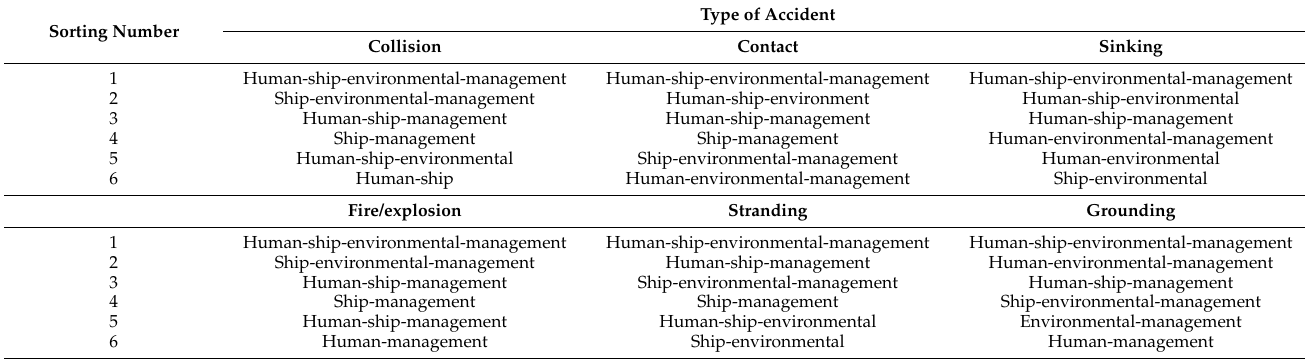
Table 10. Sorting of coupling values of different types of